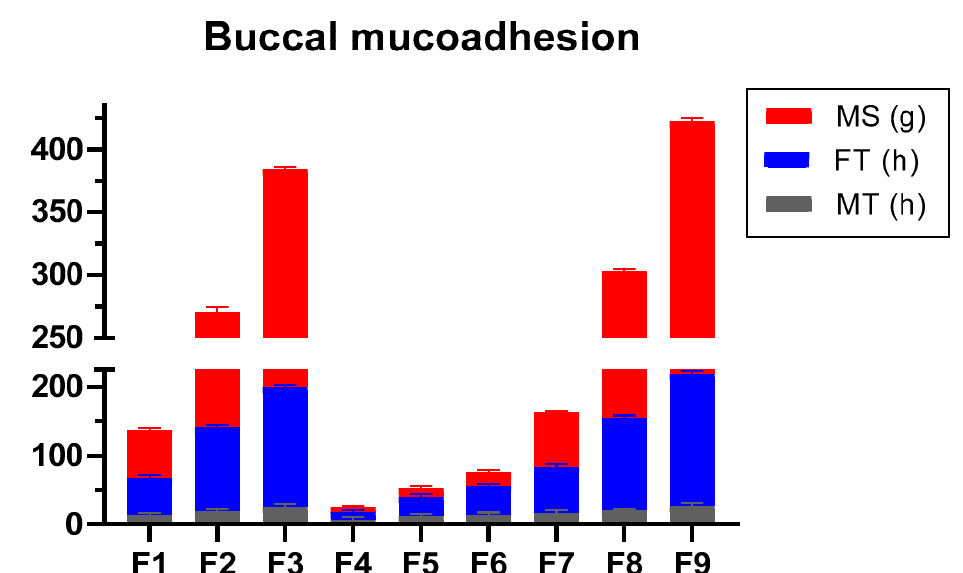
Figure 2. Mucoadhesive parameters of gel formulations.